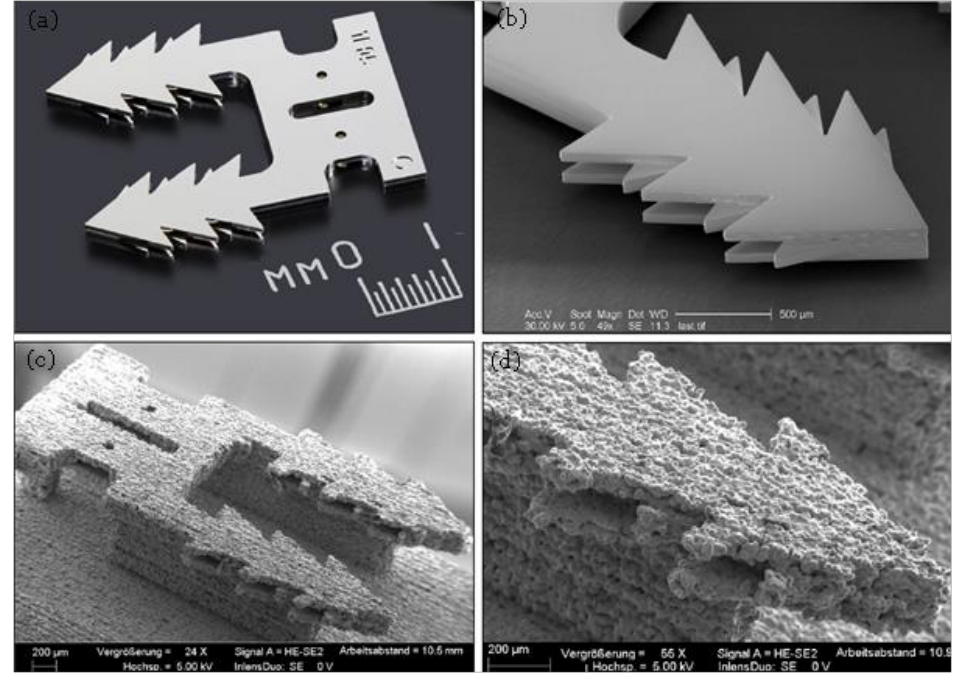
Figure 18. A metal tissue staple 3D printed using ( a , b ) EFAB (Courtesy of Microfabrica, USA) and ( c , d ) BJ technology (material 316L). Materials 2020 , 13 , x FOR PEER REVIEW